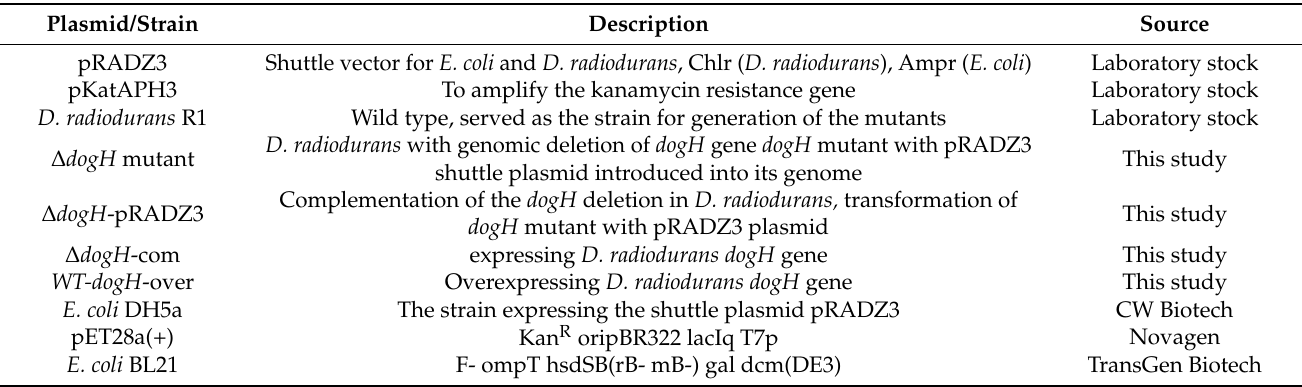
Table 3. The list of plasmids and